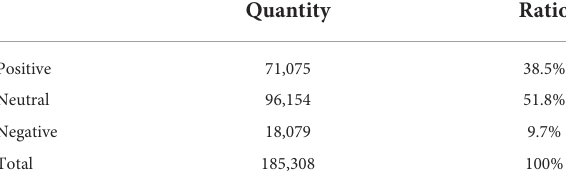
TABLE 3 Emotion distribution statistics of comment data of 24H-LS-related topics on